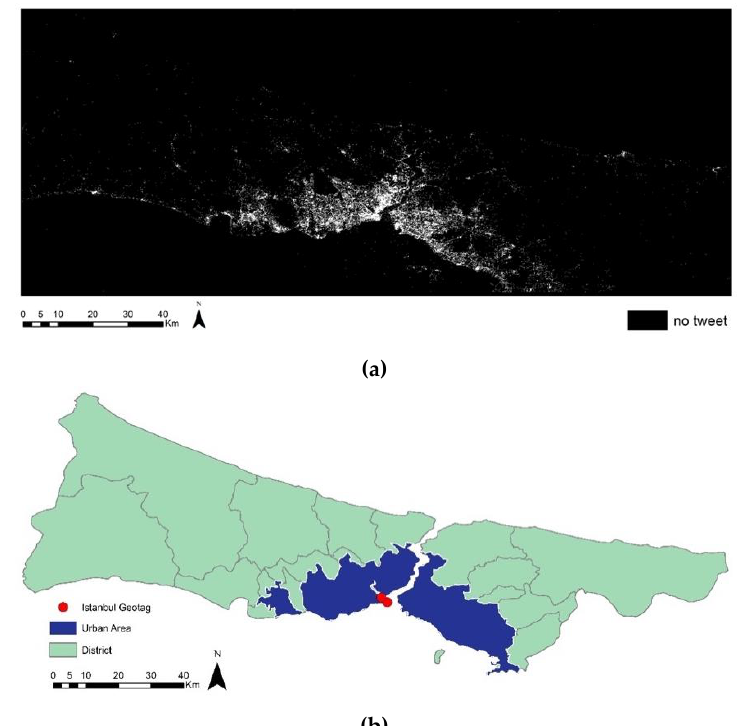
Figure 11. Istanbul city ( a ) figure and ground map for tweet representations; ( b ) urban area and social media geotags.